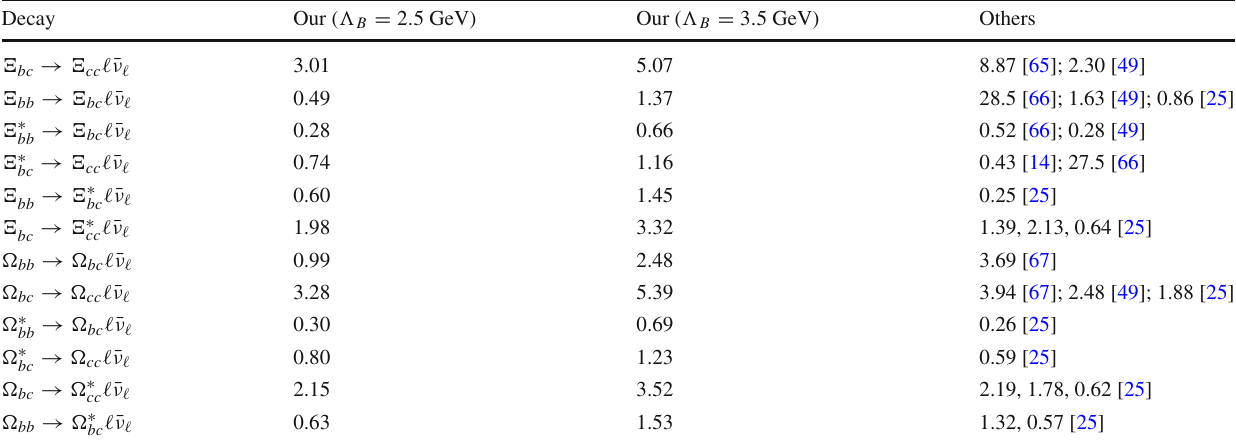
Table 5 Semeileptonic decay width of double heavy baryons (in 10 − 14 GeV ) Decay